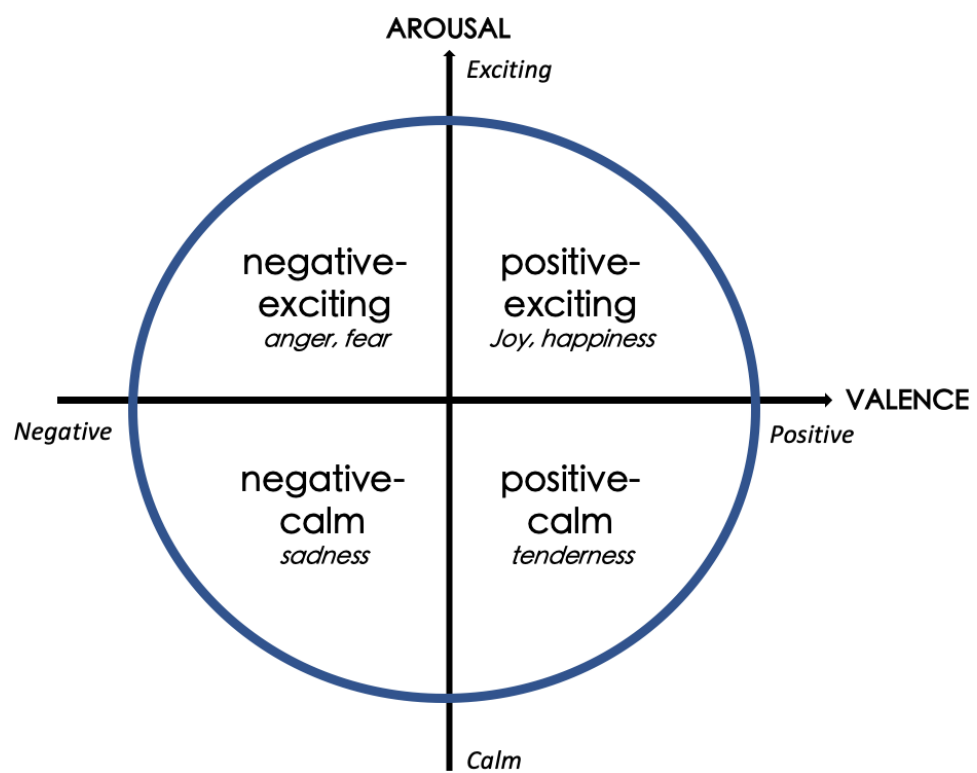
Figure 2. The circumplex valence–arousal affective model used in our study [12]. We hypothesize that the positive–exciting quadrant is more desirable than other